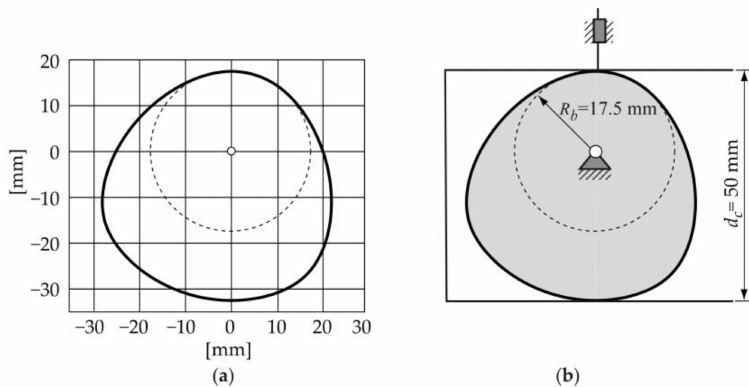
Figure 6. ( a ) Cam profile obtained, ( b ) constant-breadth cam mechanism.